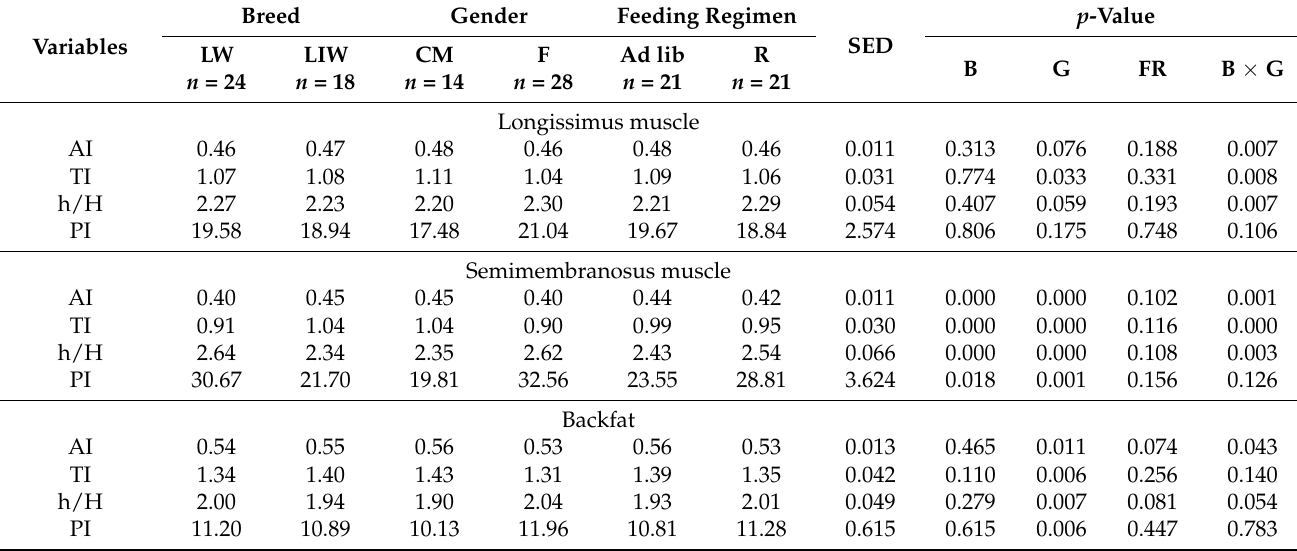
Table 8. Lipid quality indices in the intramuscular fat of muscles and backfat.